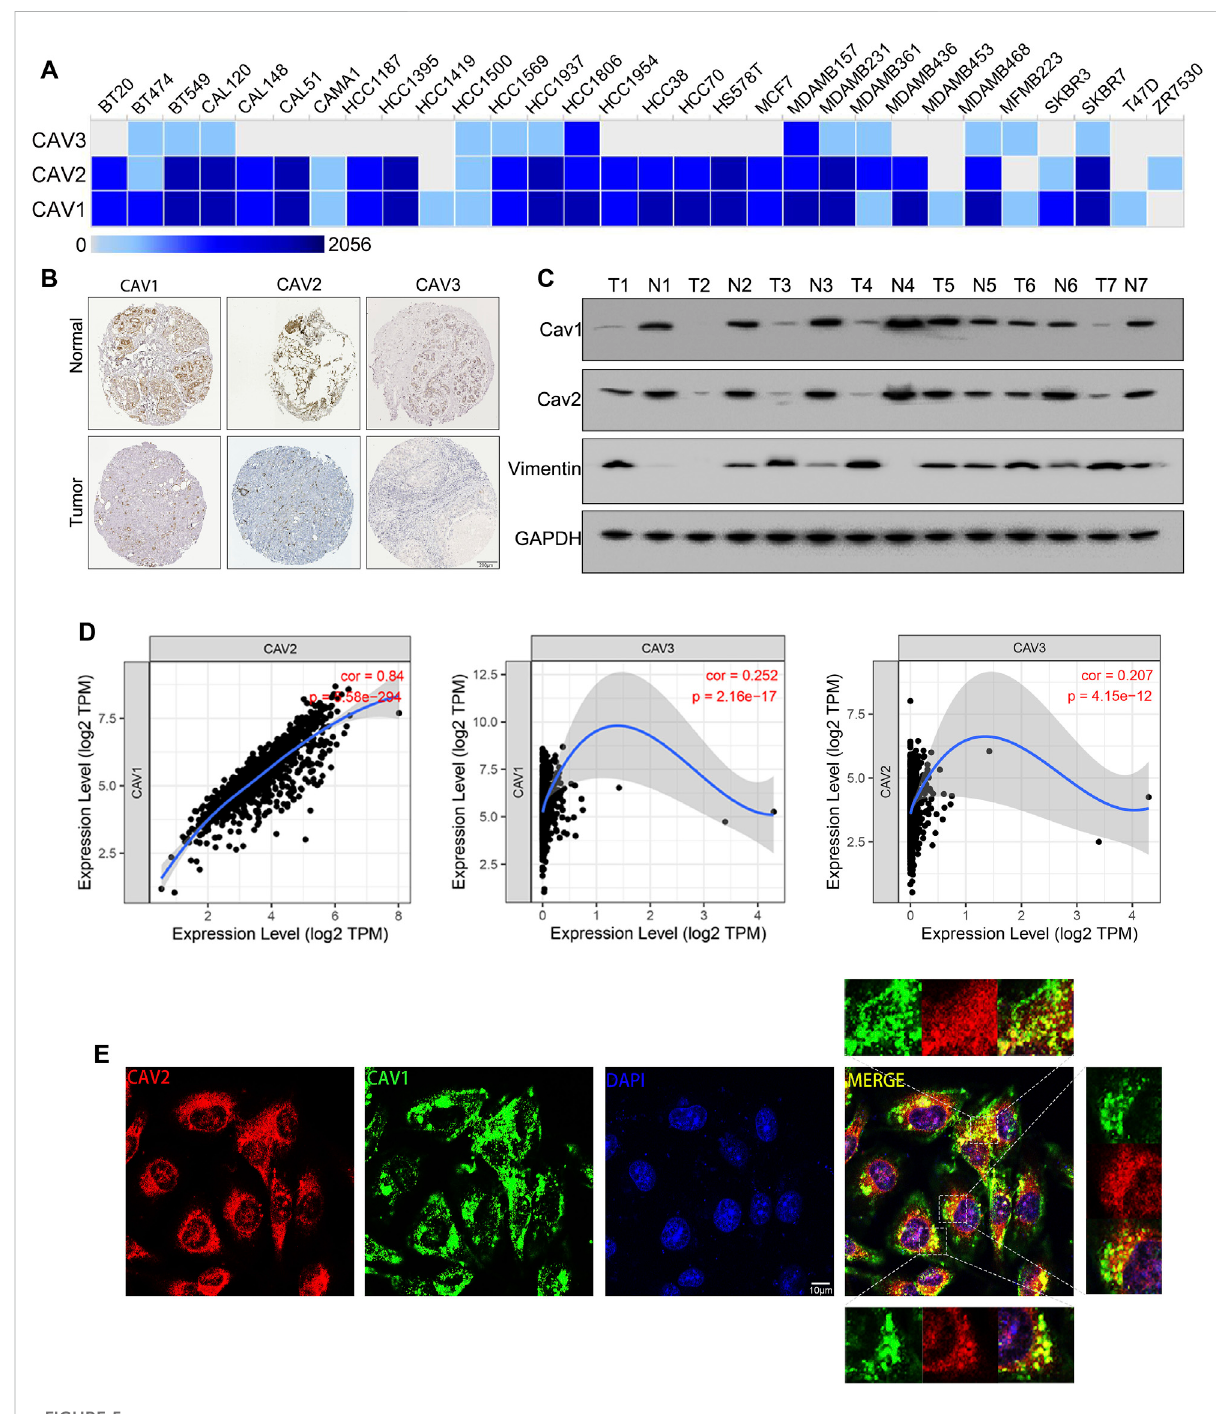
FIGURE 5 Expression of CAVs in BC cell lines and tissues. (A) Transcription expression of CAVs in 30 types of BC cancer cells (EMBL-EBI database, https:// www.ebi.ac.uk/). (B) Immunohistochemistry showed the protein expression of CAVs in BC. (C) WB analysis of the expression of CAV1, CAV2, and Vimentin in BC tissues. (D) Correlation analysis between CAV expressions in BC. (E) Double immuno fl uorescence staining displayed the co- localization of CAV1 and